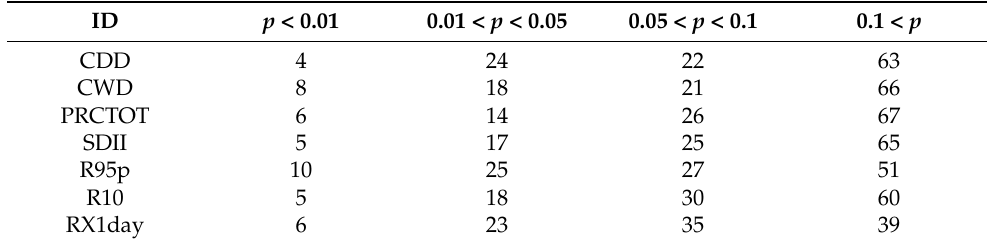
Table 2. Number of stations with significance of trends for extreme precipitation indices ( p -value).